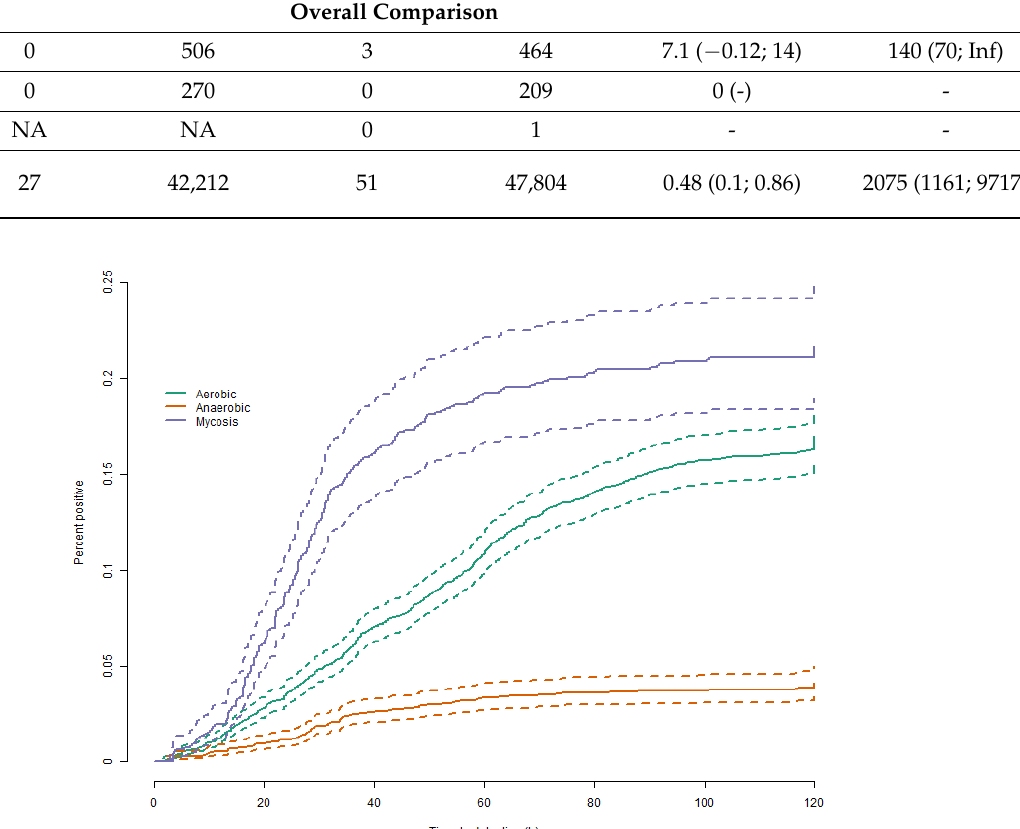
Figure 1. Time to detection of fungi-blood culture flasks: The figure shows the cumulative incidence function curves for the time to detection of fungi in each individual flask included in the study as a function of time. We found that the mycosis flasks had a lower time to detection, i.e., detected fungi faster than both aerobic and anaerobic flasks, and that the proportion of positive flasks was higher app. 0.22% for the mycosis flasks compared to appr. 0.17% for the aerobic flasks and 0.04% for the anaerobic